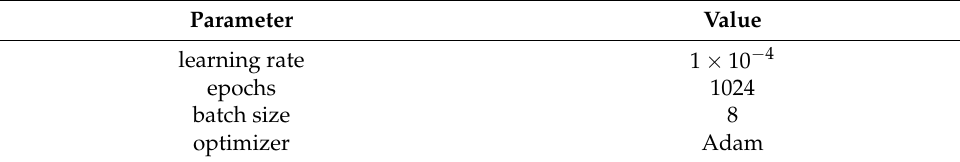
Table 1. Parameters of